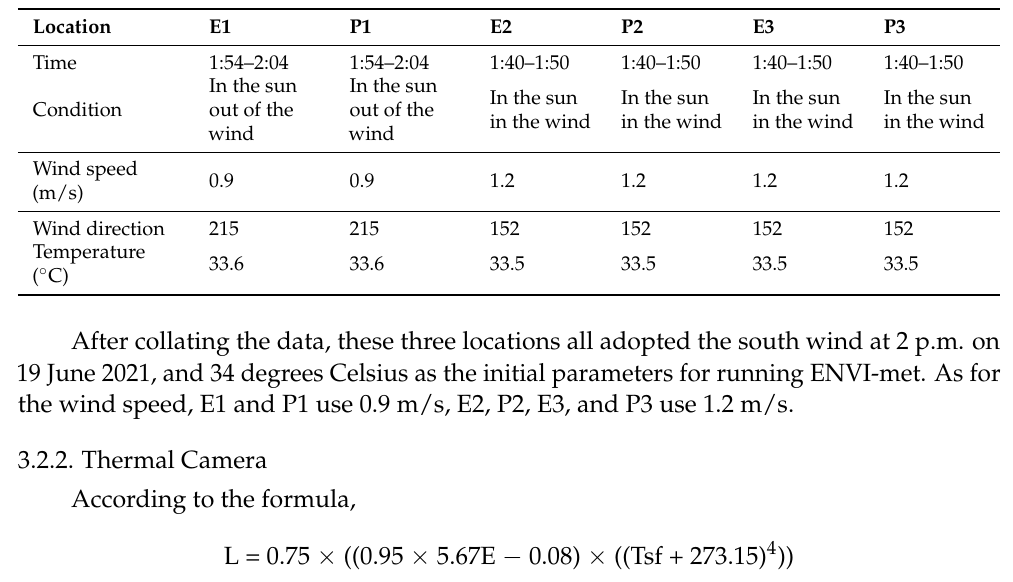
Table 2. Maxi-met Station